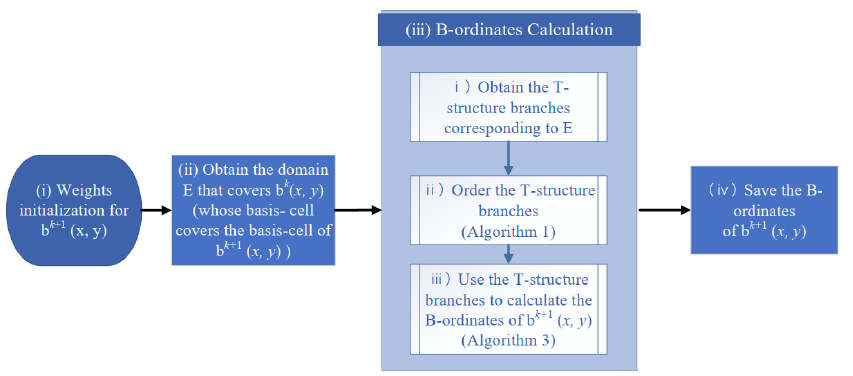
Figure 8. Process for basis